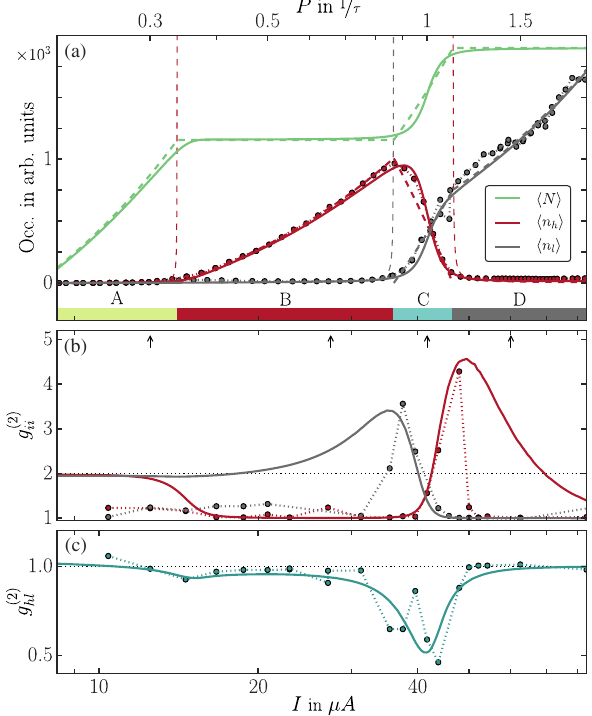
FIG. 2. Measured and calculated microcavity input-output characteristics (high-effective-gain mode in red, low-effective- gain mode in gray). The injection current I is proportional to the pump rate P . Here, circles (connected to guide the eye), solid curves, and dashed curves refer to experimentally measured data, exact Monte Carlo results, and asymptotic mean-field theory, respectively. Panel (a) depicts the mean occupations of the modes and the number of excited carriers (light green) in arbitrary units. The colored bars at the bottom of this panel mark the phases determined by the asymptotic theory (see Sec. IV C). Panel 2 Þ (b) shows the autocorrelation g ð for both modes in comparison ii with the value 2 expected for thermal emission (dotted black 2 Þ line). Panel (c) depicts the cross-correlation g ð in comparison to hl the value 1 for correlated emission (dotted black line). For the theoretical curves, we use s ¼ 0 , G ¼ 0 . 77 , as well as (in units of 1 . 6 × 10 − 3 , g 2 . 1 × 10 − 3 the spontaneous loss rate τ − 1 ) g h ¼ l ¼